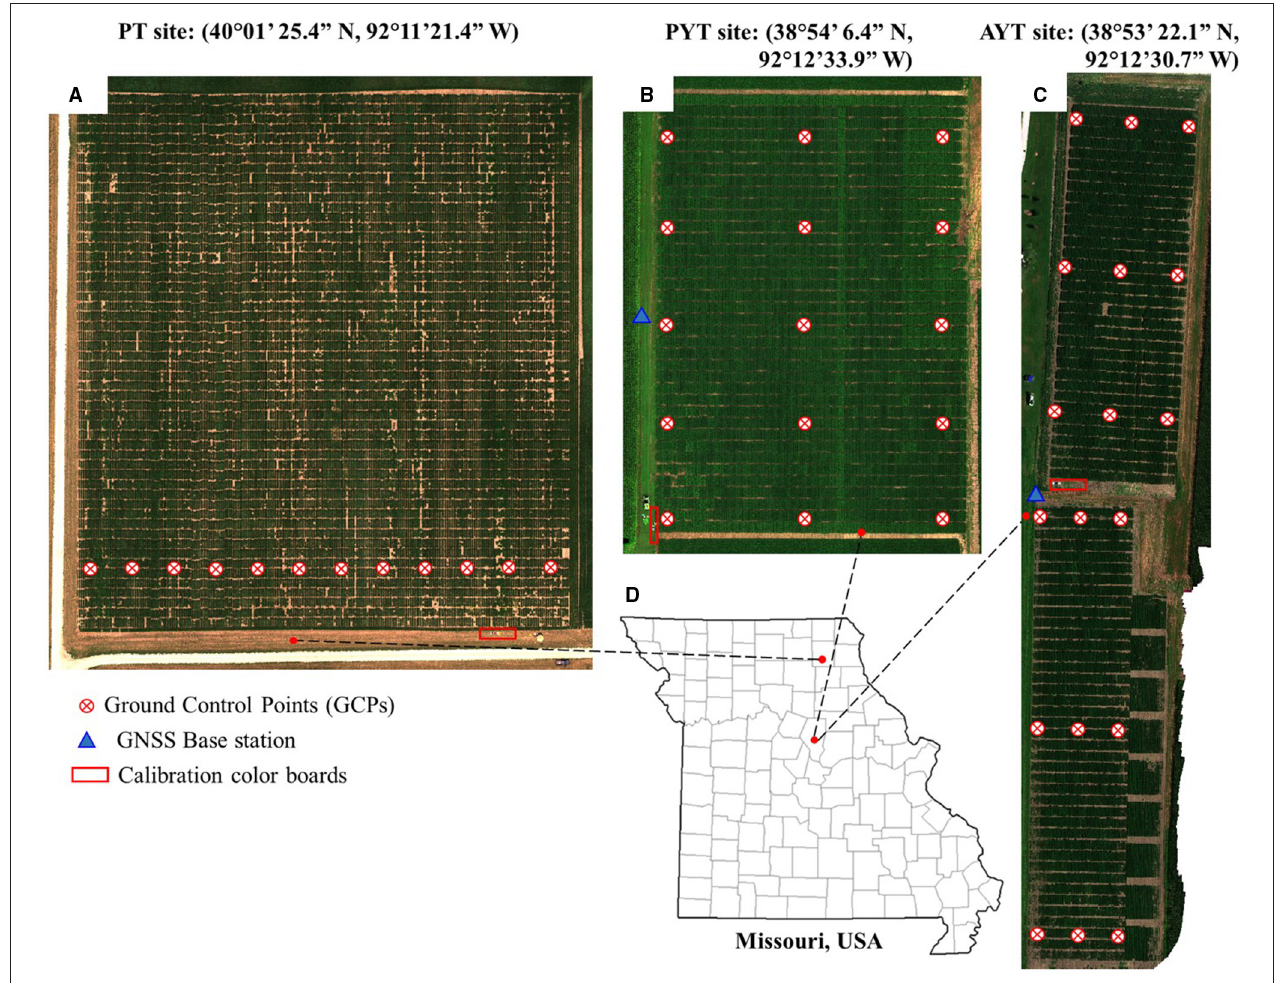
FIGURE 1 | Locations of field trials. (A–C) are fields and distribution of ground control points (GCPs) at the progeny trial (PT) in 2018, the preliminary yield trial (PYT) in 2019, and the advanced yield trial (AYT) in 2020, respectively. (D) Geographical locations of the fields.